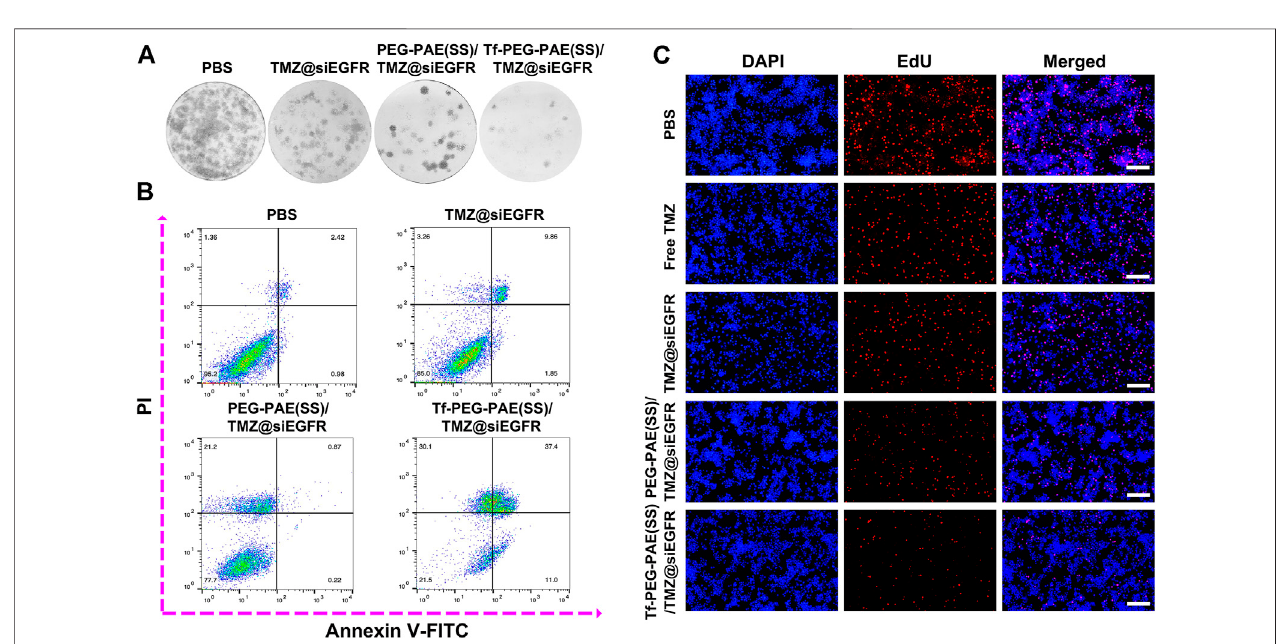
FIGURE 6 | (A) Clonogenic formation of U87 cells treated with PBS, TMZ@siEGFR, PEG-PAE(SS)/TMZ@siEGFR, or Tf-PEG-PAE(SS)/TMZ@siEGFR. (B) Analysis ofapoptoticU87cellsculturedwithPBS,TMZ@siEGFR,PEG-PAE(SS)/TMZ@siEGFR,orTf-PEG-PAE(SS)/TMZ@siEGFRby fl owcytometry. (C) Representativeimages of EdU assays cultured with PBS, free TMZ, TMZ@siEGFR, PEG-PAE(SS)/TMZ@siEGFR, or Tf-PEG-PAE(SS)/TMZ@siEGFR.